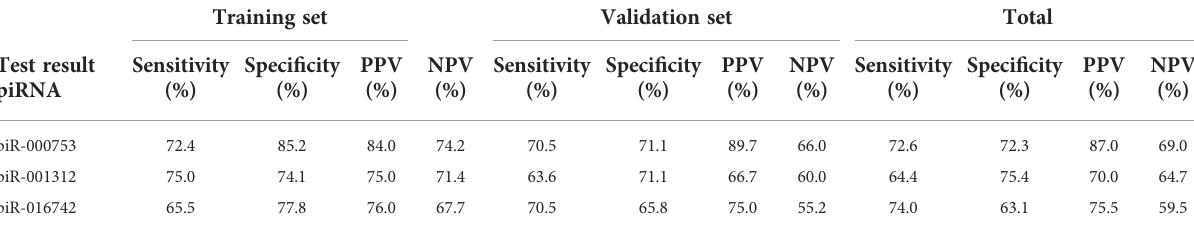
TABLE 3 Diagnostic ef fi cacy of piR-000753, piR-001312, and piR-016742 to differentiate brucellosis patients from control individuals. Training set Validation